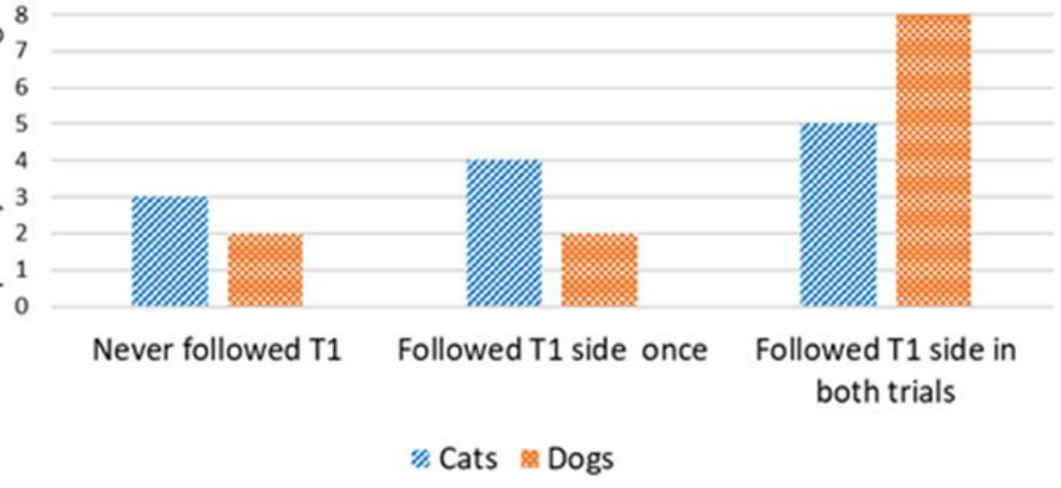
Figure 5. Control group: frequency of following the same side as in Trial 1, during Trial 2 and Trial 3 (cats vs. dogs).